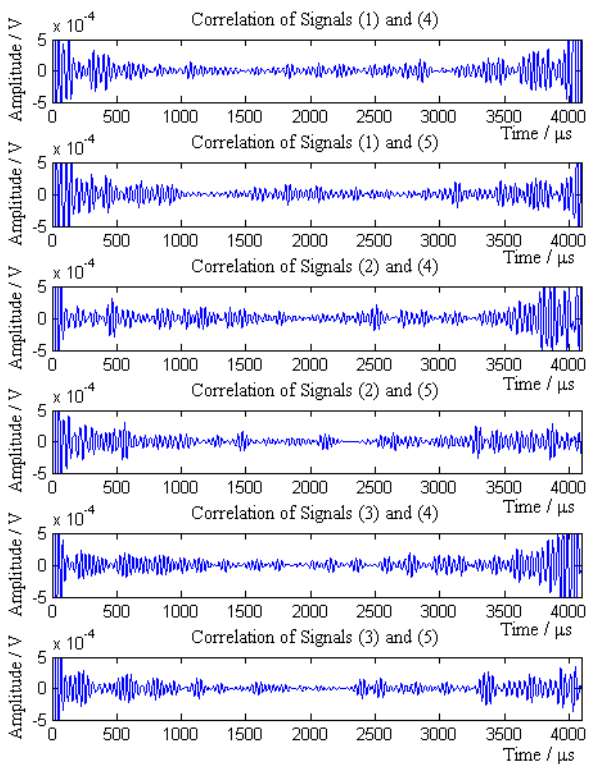
Figure 13. Correlation result of each pair of